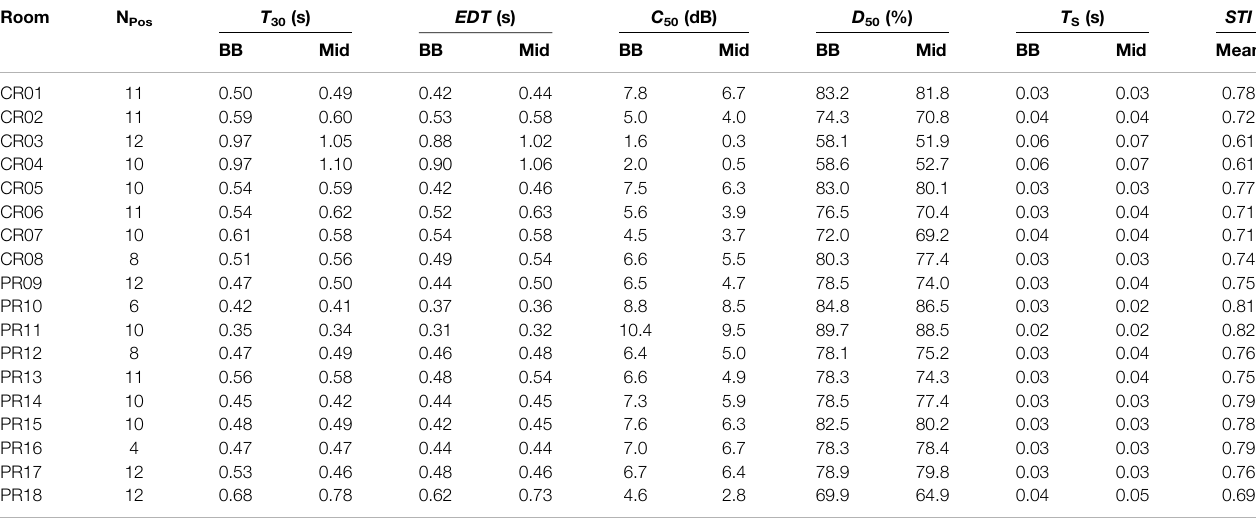
TABLE 3 | Room acoustic parameters from omnidirectional microphone for classrooms (CRs) and playrooms (PRs).